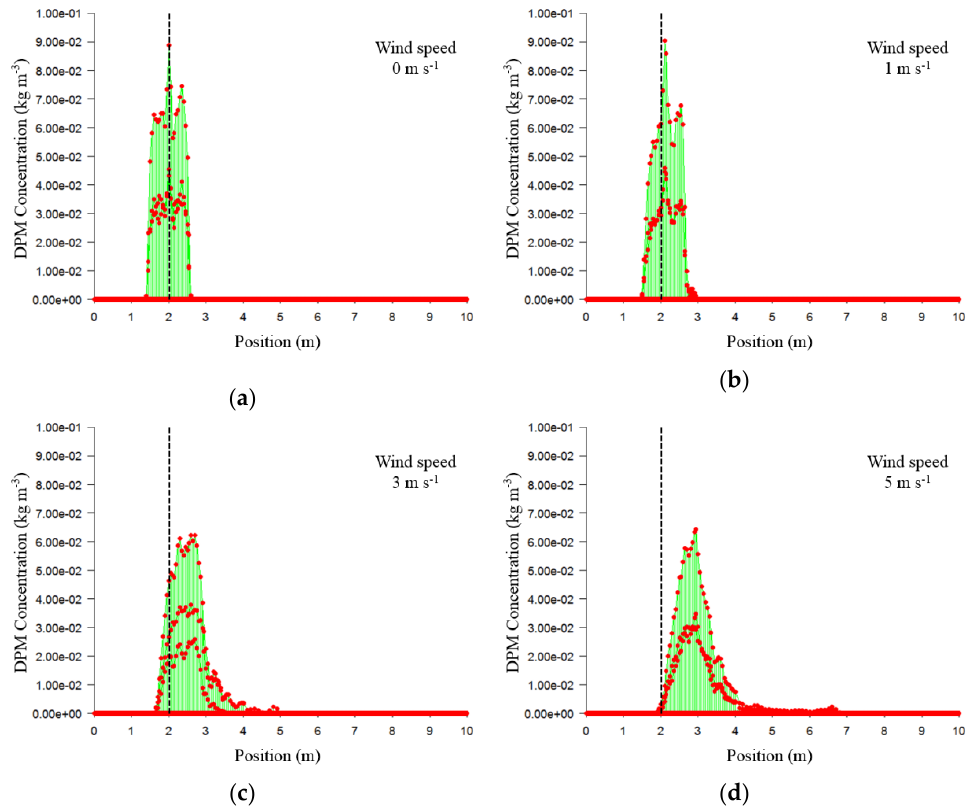
Figure 5. Concentration of droplets deposition at different wind speeds, ( a ) 0 m s − 1 , ( b ) 1 m s − 1 , ( c ) 3 m s − 1 , and ( d ) 5 m s − 1 . X-axis indicates a different position of target area and off-target area. Y-axis shows DPM concentration (kg m − 3 ) of droplets deposition at different wind speeds, 0 m s − 1 , 1 m s − 1 , 3 m s − 1 , and 5 m s − 1 . The point means concentration of different position, the dotted line means the droplet concentration deposition center, and the solid line means the biggest concentration of corresponding point.